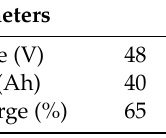
Table 4. Battery discharge parameters.